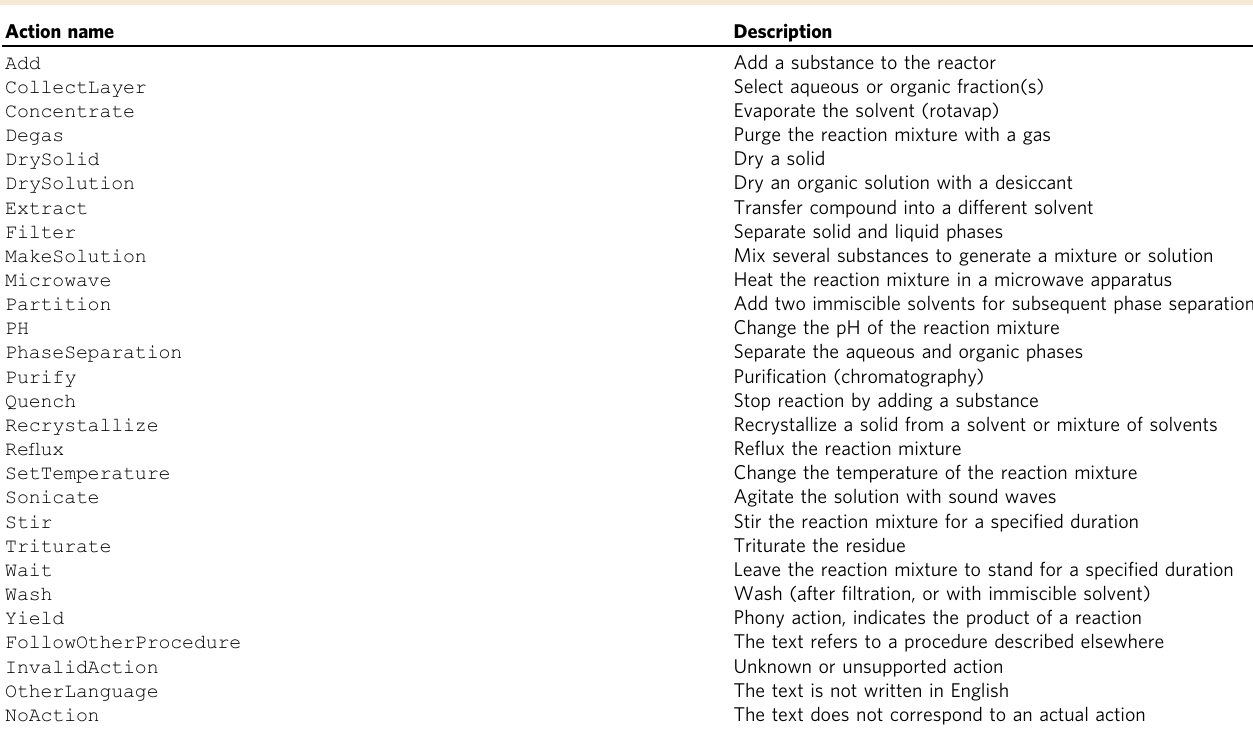
Table 1 Action types for information extraction from experimental